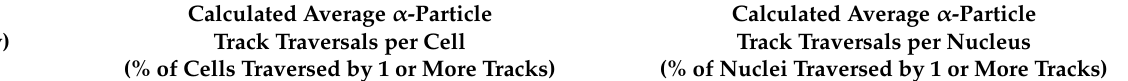
Table 1. The variation in the average number of alpha-particle track traversals per cell and per nucleus for the HF19 cell line and corresponding calculated percentages of nuclei and cells traversed as a function of the alpha-particle dose. The calculations were based on average cellular and nuclear areas of 1557 µ m 2 and 189 µ m 2 , respectively.